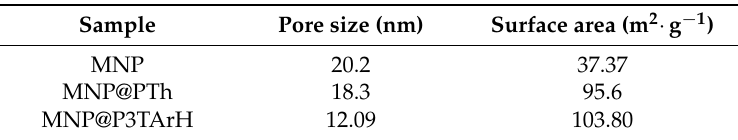
Table 1. BET pore size and surface area.